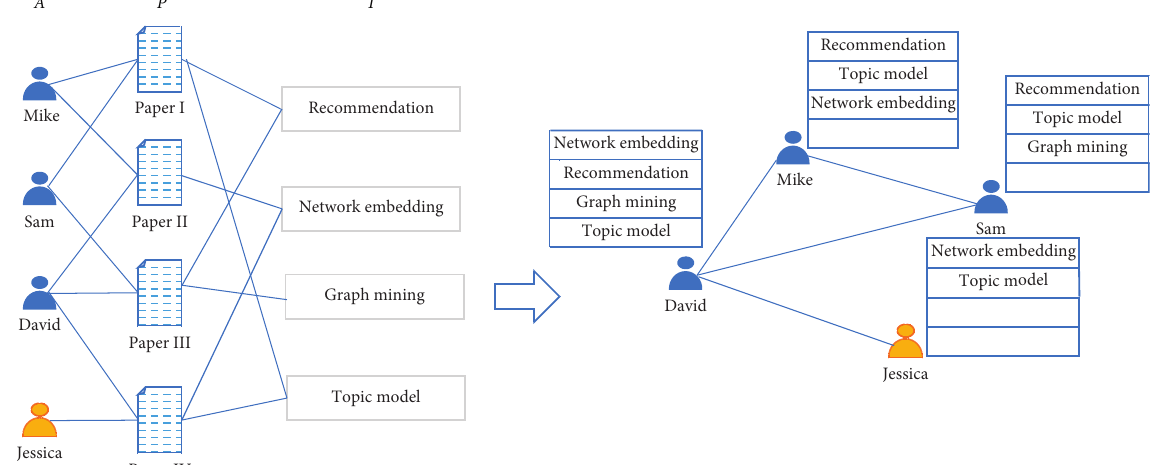
Figure 1: The extraction of a collaboration network with attributes from academic data. A is a list of researchers, P is a list of papers, and T is a list of topics. Each researcher has a distribution of topics. In this paper, we regard each word in the title of the paper as a topic. The figure shows that if two researchers coauthor a paper, there is a link between them, such as (David, Jessica). If a researcher has coauthored more papers, he will have more links with others, such as (David, Mike), (David, Sam), and (David,